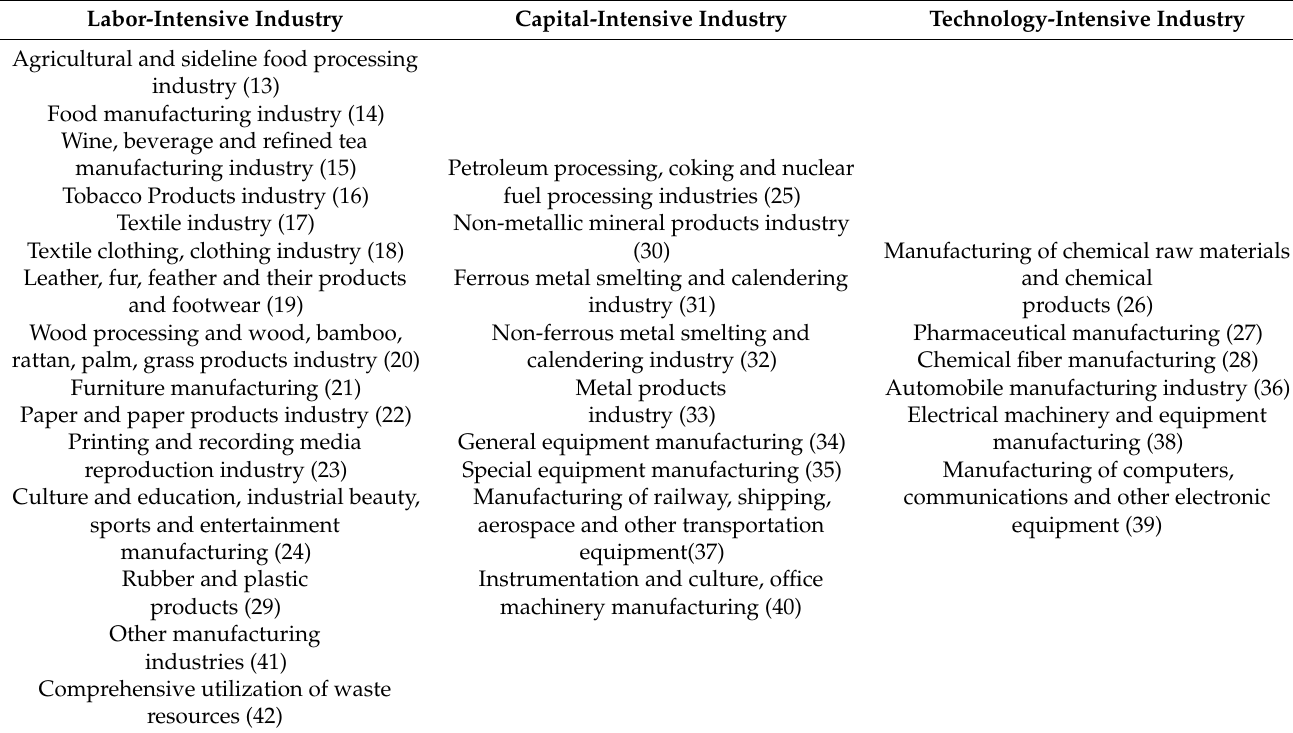
Table 2. Industry classification by factor intensity (30